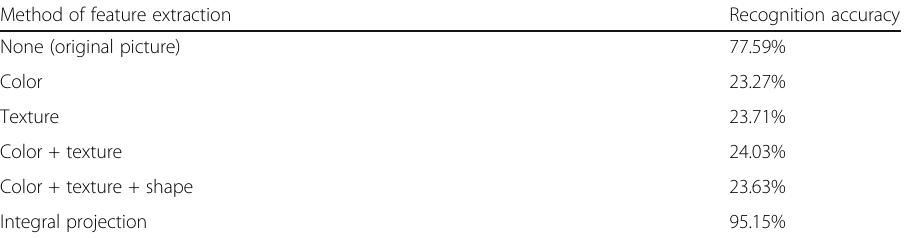
Table 4 The recognition accuracy using different methods of feature extraction in SAE Method of feature